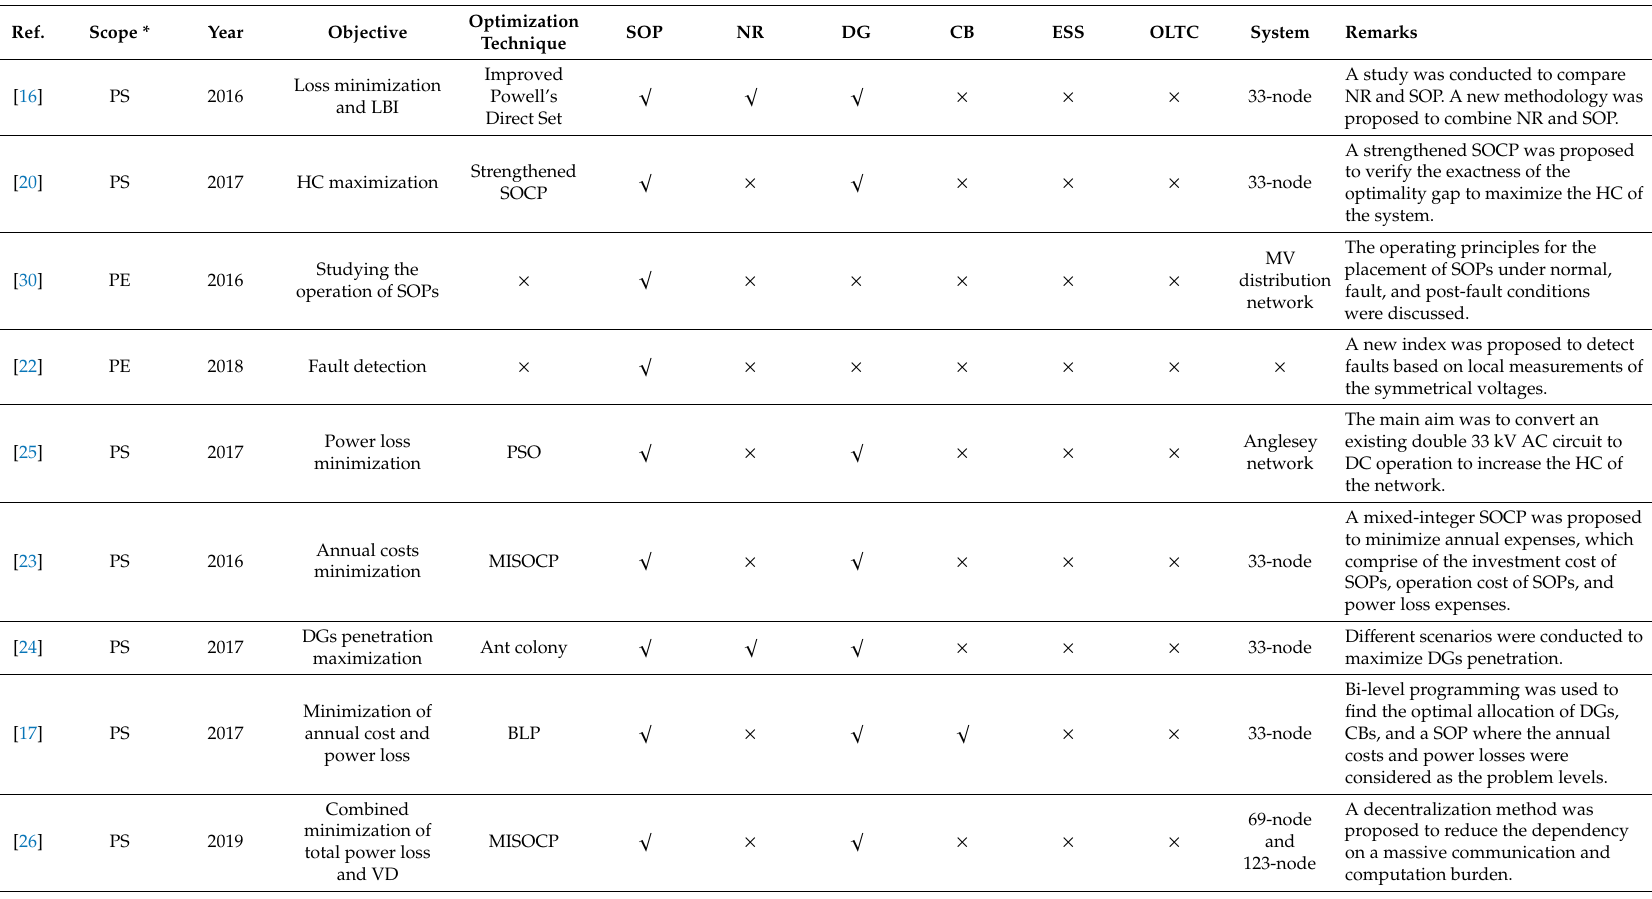
Table 1. Overview of research works addressing SOPs’ design and